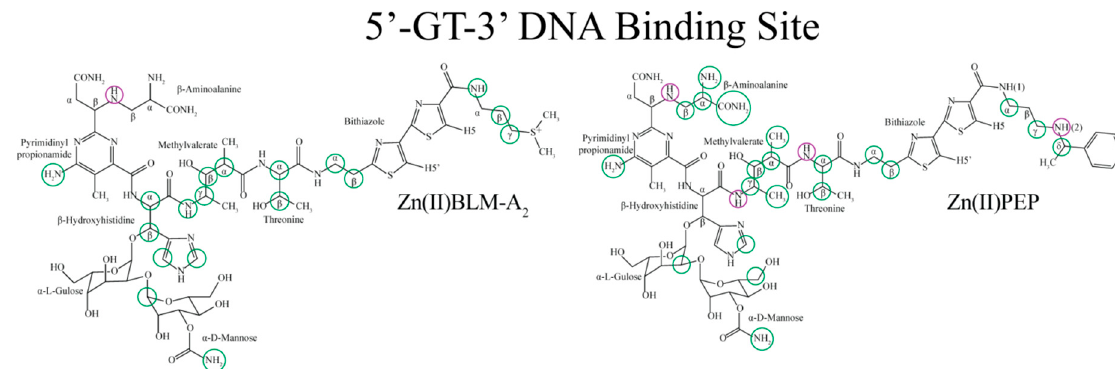
Figure 3. Protons exhibiting significant shifts in their OL 2 -bound forms (green circles) and protons that could not be assigned in the bound forms (purple circles) for spectra acquired in H 2 O at 5 °C.